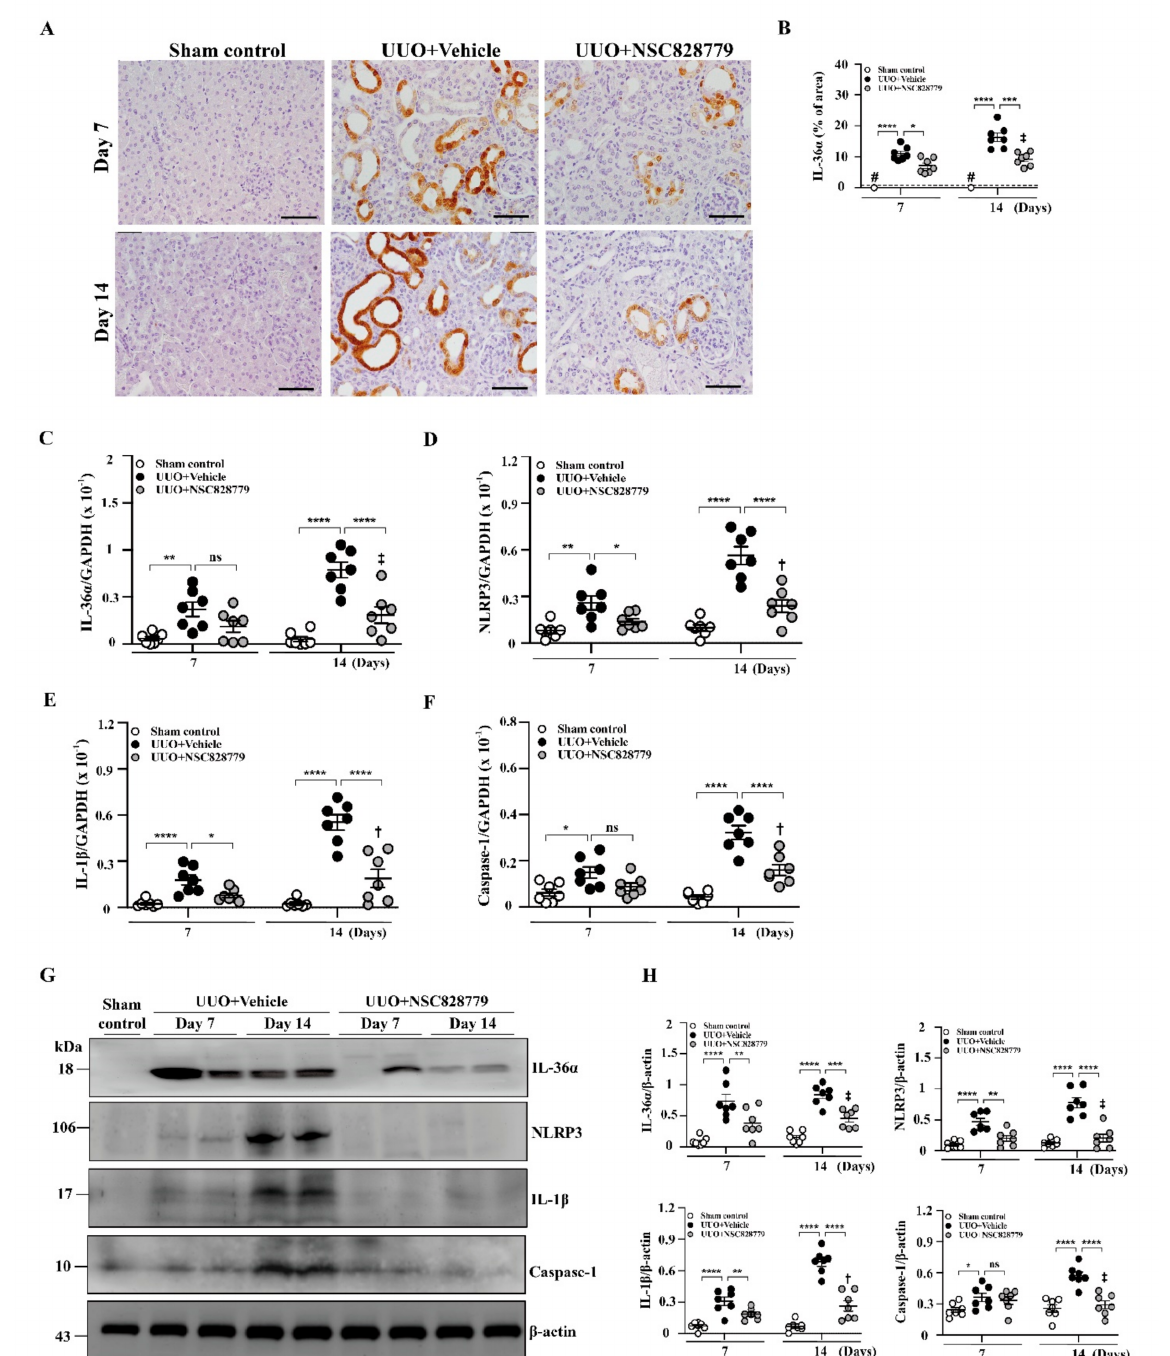
Figure 3. Renal IL-36 α expression and NLRP3 inflammasome activation in UUO mice. ( A , B ) IHC and scoring for IL-36 α . Original magnification, each 400 × . Real-time PCR assay for mRNA levels of renal IL-36 α ( C ), NLRP3 ( D ), IL-1 β ( E ), and caspasae-1 ( F ). Western blot analysis for renal ( G ) IL-36 α , NLRP3, IL-1 β , and caspase-1. ( H ) Semi-quantitative analysis. Data are shown as means ± SEM of seven mice per group. The horizonal dashed line indicates the mean for sham control + NSC828779. NSC828779, a salicylanilide derivative. UUO, unilateral ureter obstruction. #not detectable. ns, no significant difference. * p < 0.05, ** p < 0.01, *** p < 0.005, **** p < 0.001. † p < 0.05 Day 7 versus Day14 of UUO +